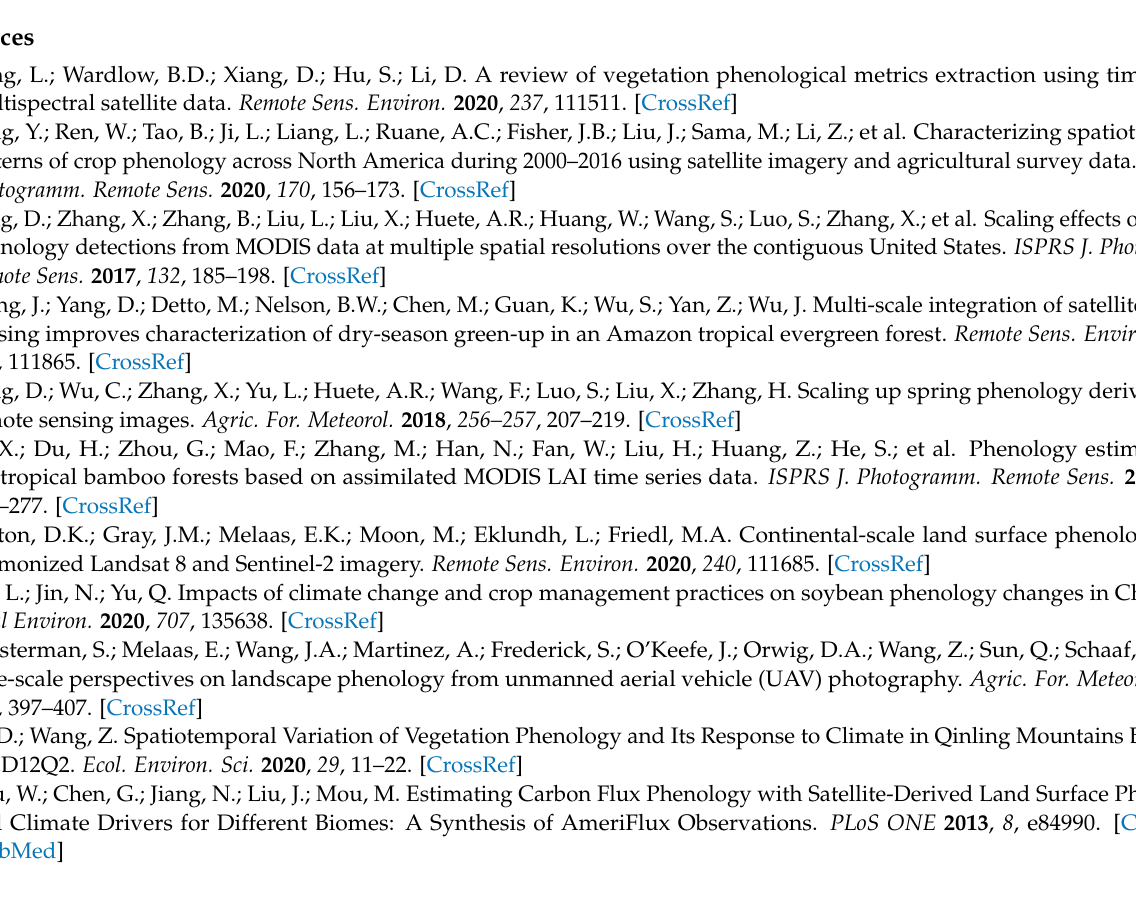
Figure A4. Up-scaled EOSs from 1000 m EOSs. (SG, Savitzky-Golay; AG, asymmetric Gaussian; DL, double